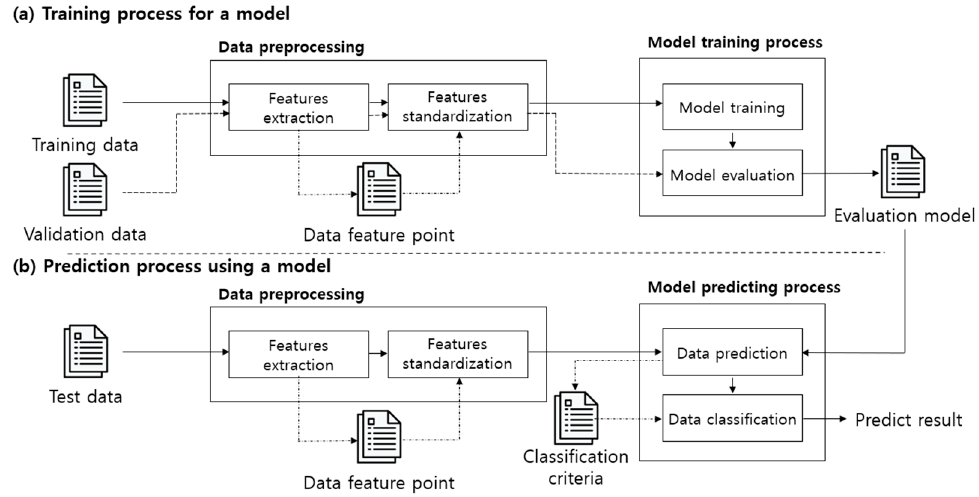
Figure 4. Deep learning training, and prediction process: ( a ) training process for a model; ( b ) prediction process using a model.